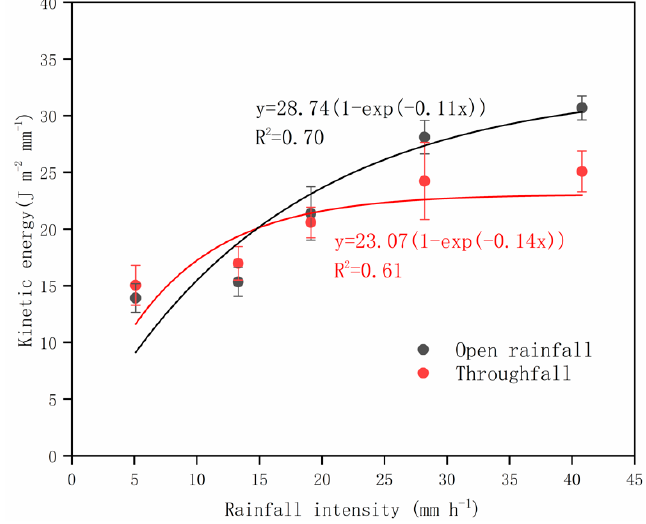
Figure 6. Scatter plot of kinetic energy versus rainfall intensity with exponential law.